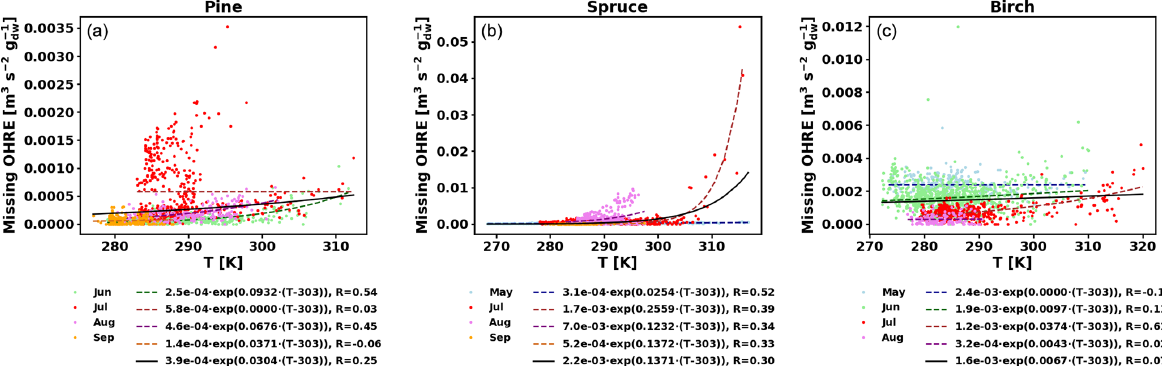
Figure E2. Missing OHRE temperature dependence by month (coloured dots and dotted line fits) and fit for all data combined (black solid line) for pine (a) , spruce (b) , and birch (c)